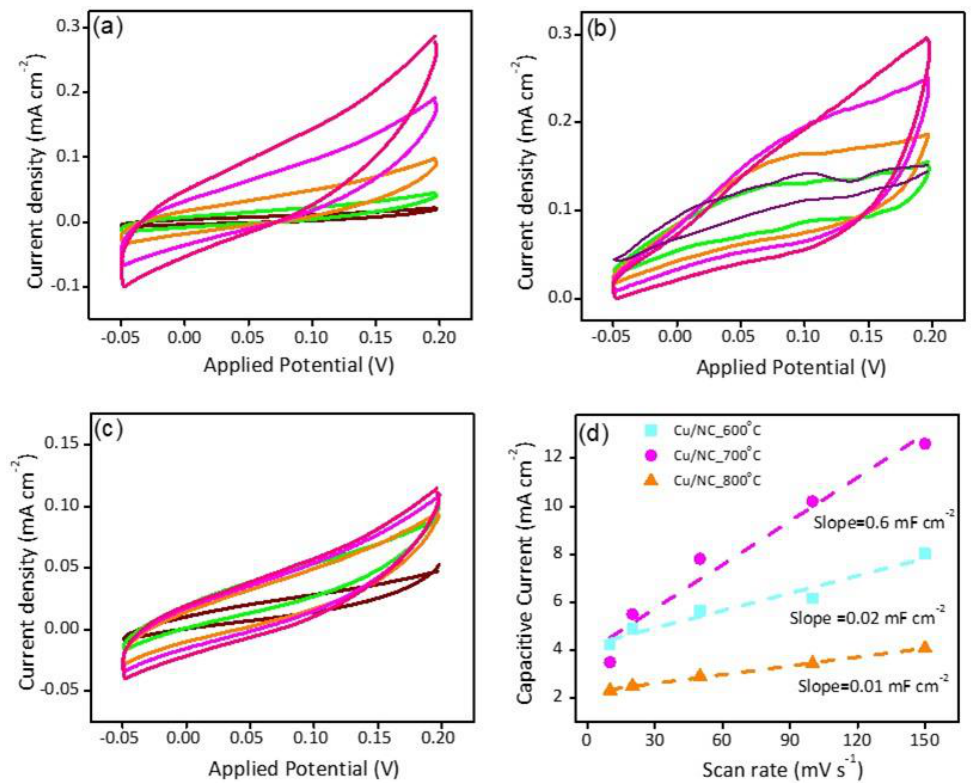
Figure 6. CVs of ( a ) Cu-NP/NC-600, ( b ) Cu-NP/NC-700, ( c ) Cu-NP/NC-800 electrocatalysts in CO 2 saturated 0.5 M KHCO 3 electrolyte, and ( d ) is the respected C dl slopes of the electrodes. The scan rate (a to c) purple: 50 mVs − 1 , Green: 100 mVs − 1 , Orange: 150 mVs − 1 , Magenta: 200 mVs − 1 , Pink: 250 mVs − 1 .